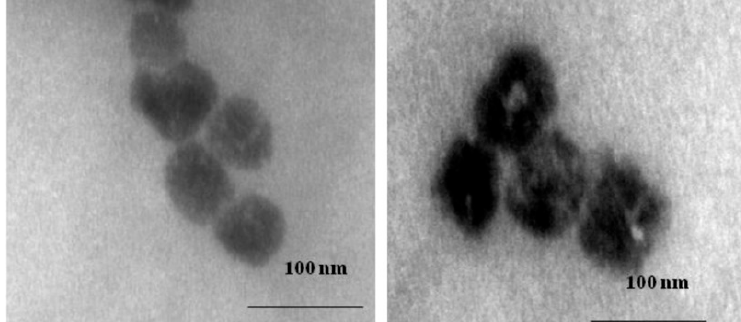
Figure 3. TEM micrographs of an epoxidized LO/CuO nanocomposite. Reprinted from [50], copyright 2013, with permission from Elsevier.